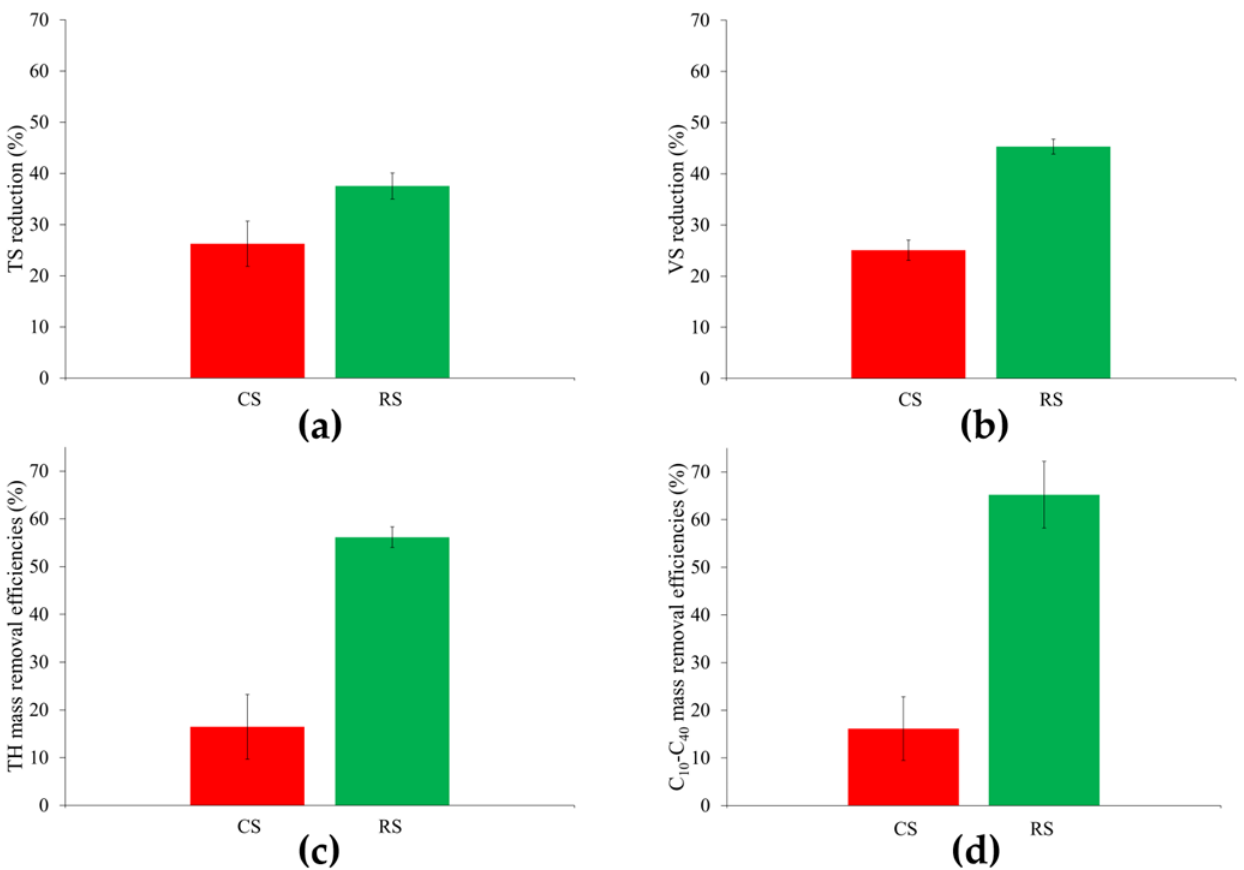
Figure 3. TS ( a ) and VS ( b ) reductions and TH ( c ) and C 10 -C 40 ( d ) mass removal efficiencies due to AD for RS (green line) and CS (red line).